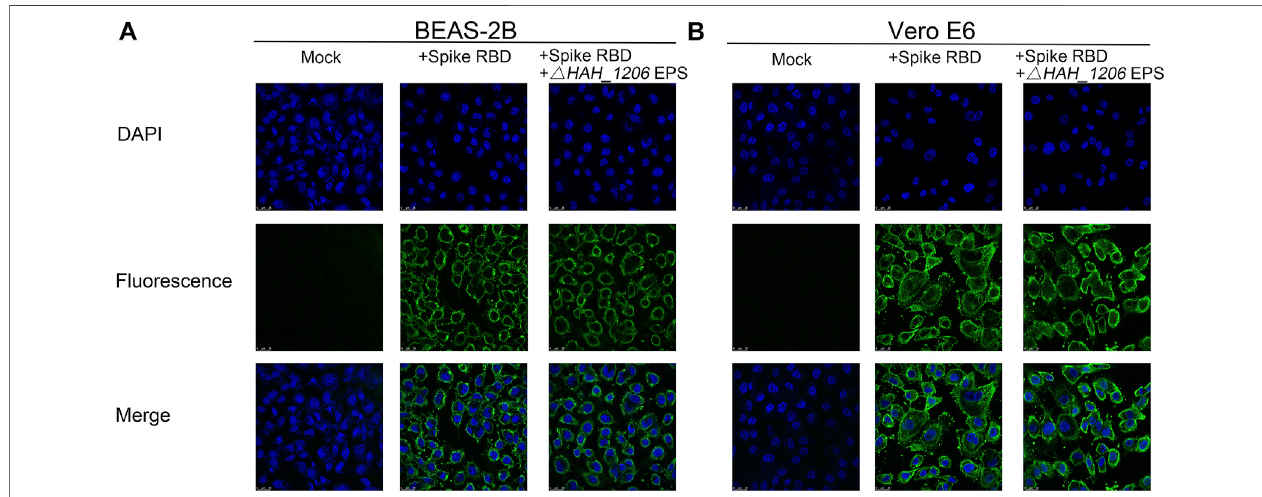
FIGURE 4 | Immuno fl uorescence assay of EPSs from △ HAH_1206 toward binding of RBD to BEAS-2B and Vero E6. (A) In fl uence of EPSs from △ HAH_1206 on binding of RBD to BEAS-2B cells. (B) In fl uence of EPSs from △ HAH_1206 on binding of RBD to Vero E6. Mock : cells detected in the absence of RBD and EPSs; + Spike RBD : cells detected in the presence of RBD (1 μ g/well); and + Spike RBD + EPSs from △ HAH_1206 : cells detected in the presence of RBD (1 μ g/well) and EPSs (2 μ g/well). All wells were detected by immuno fl uorescence using SARS-CoV-2 (2019-nCoV) spike-neutralizing antibody and Alexa Fluor 488 goat anti- mouse IgG (H + L) by using a confocal microscope. The fl uorescence signals were captured with an FITC channel, and the nuclear DNAs of cell were stained with DAPI.